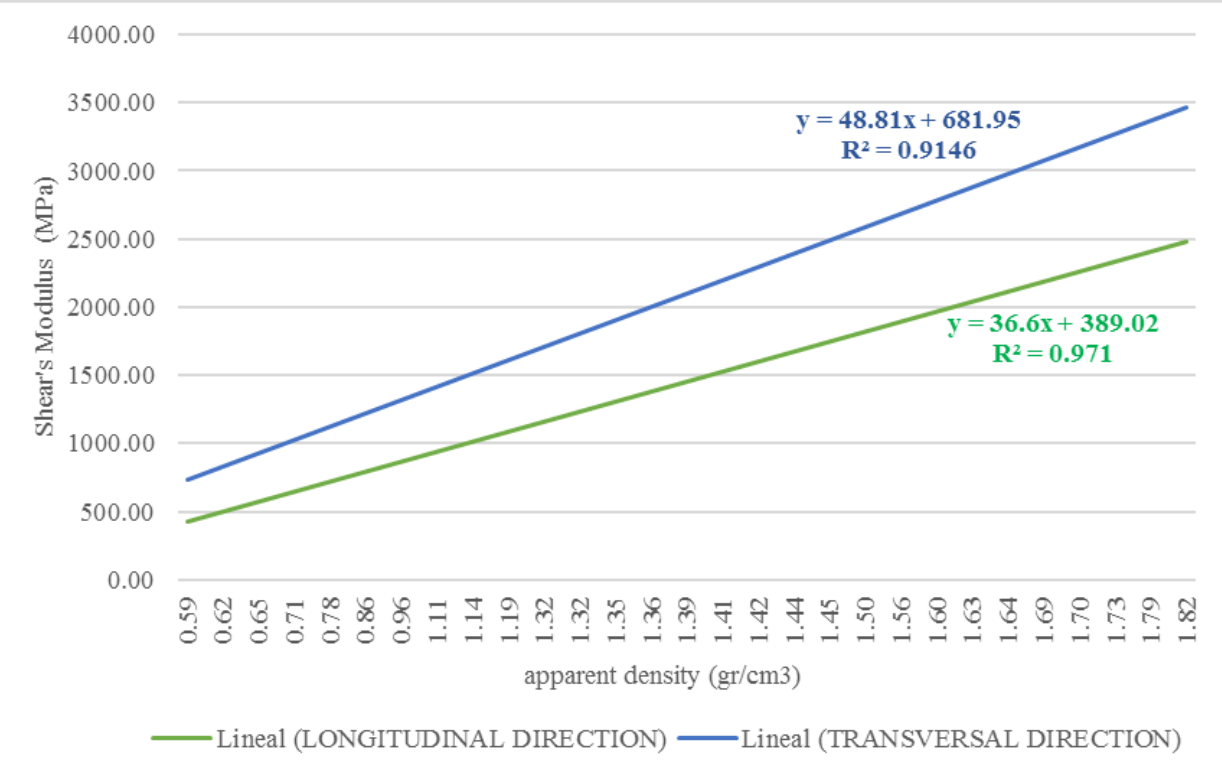
Figure 7. Relationship between apparent density and Poisson’s coefficient for bone tissue affected with OI: ( a ) cortical tissue; ( b ) trabecular tissue.